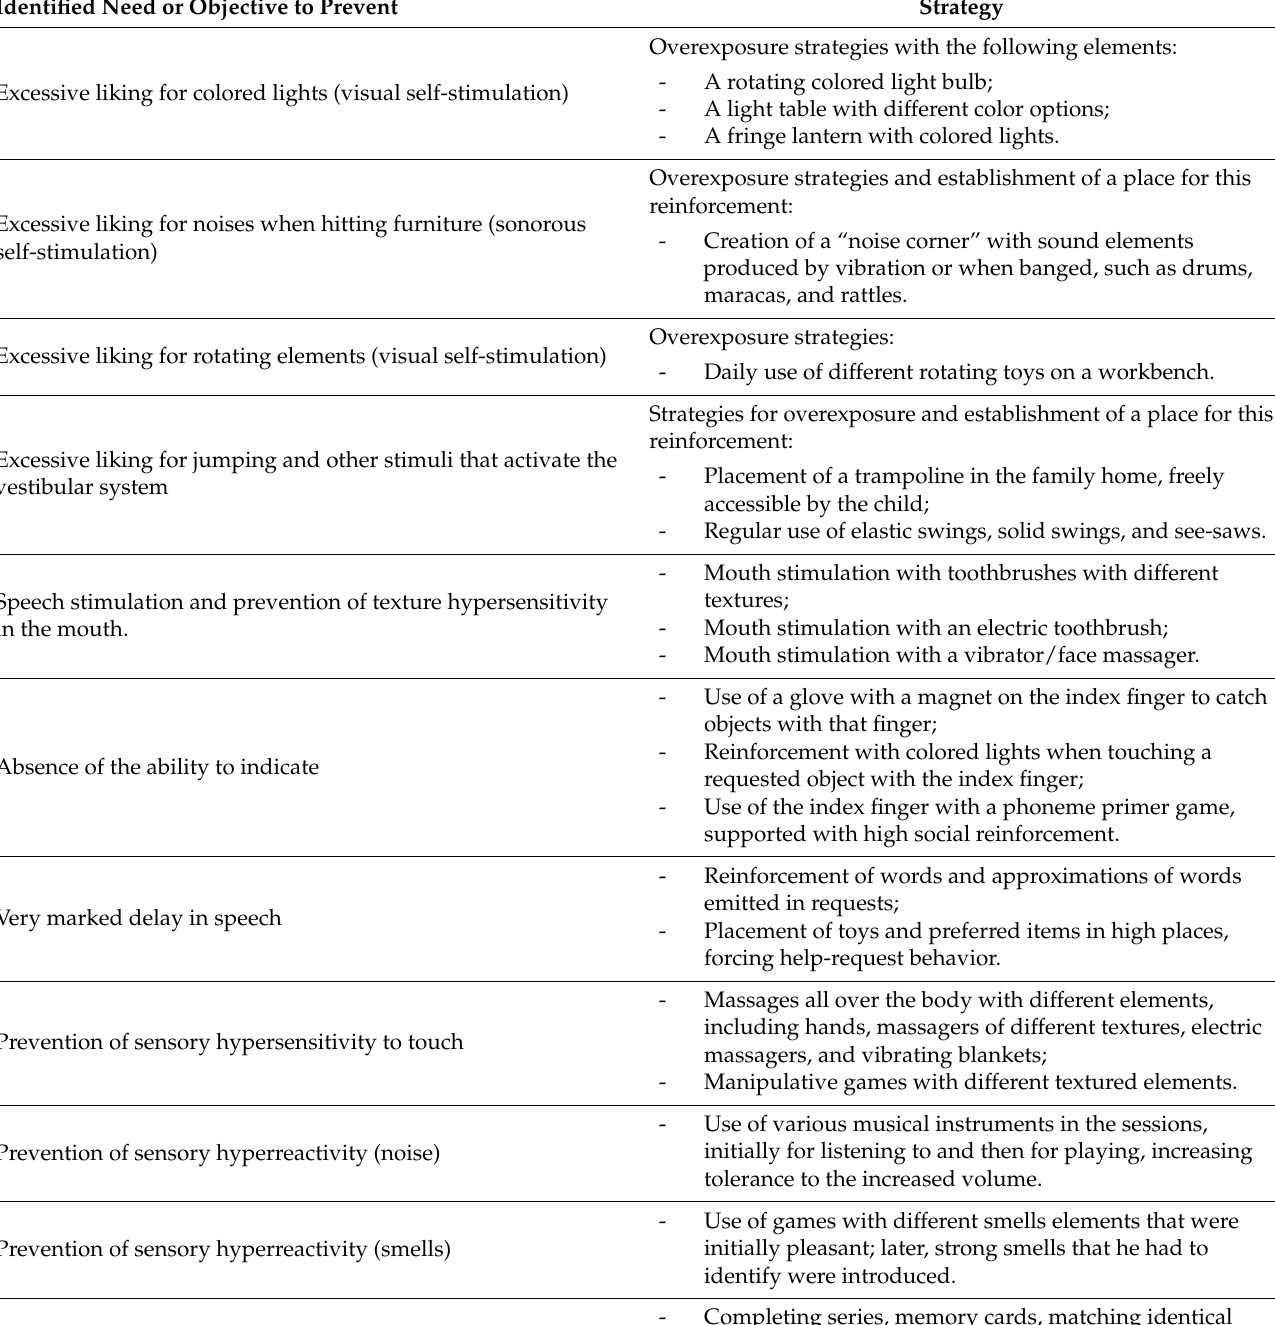
Table 1. Affected or planned areas as preventive work objectives and strategies designed for the